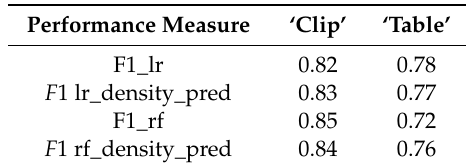
Table 6. Estimates of prediction performance for spike shape type for one (‘table’) and four (‘clip’) projections (F1_lr and F1_rf, the F 1 measure for the accuracy of spike classification according to density by logistic regression and random forest methods; F 1 lr_density_pred and F1 rf_density_pred, the F 1 measure for the classification accuracy using an additional parameter, predicted density index, by logistic regression, and random forest methods).